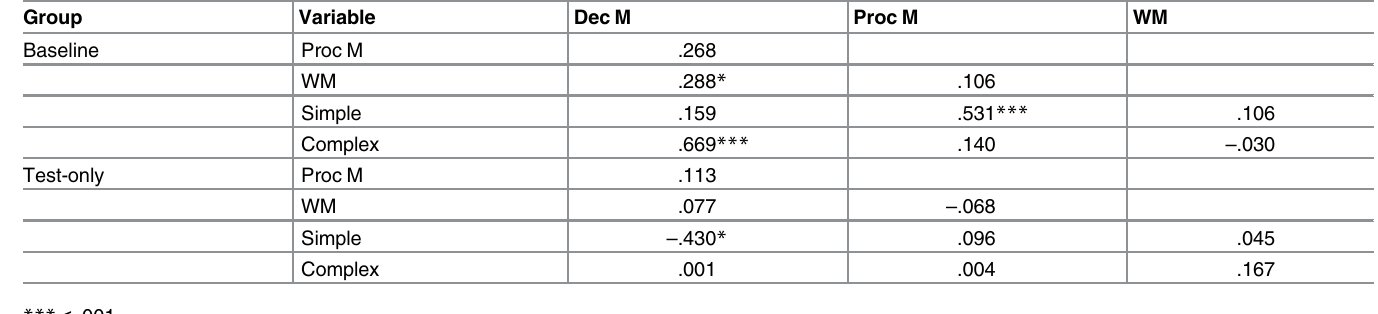
Table 2. Pearson correlations between the memory measures and learning of the simple and complex grammatical patterns by the baseline and test-only groups. Group Variable Dec M Proc M WM Baseline Proc M